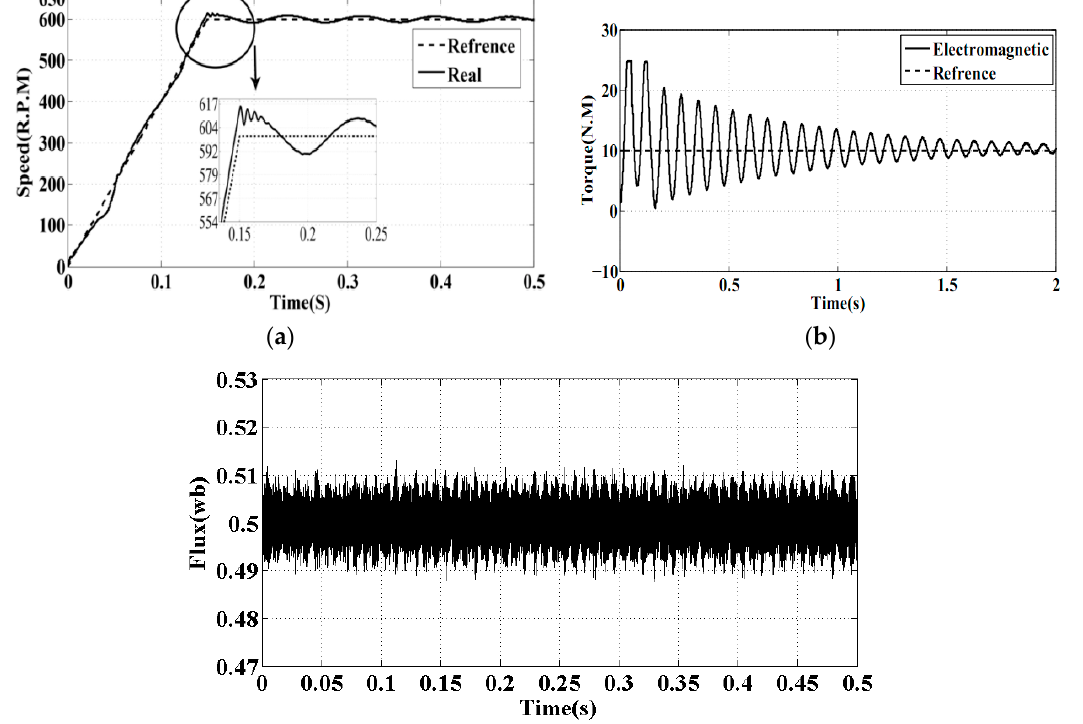
Figure 16. Characteristics of the motor compared with the reference (without correction). ( a ) Speed of the motor; ( b ) electromagnetic torque; ( c ) stator flux in the α axis of the stationary frame. Table 5. Characteristics of the motor speed curve without using the correction method.